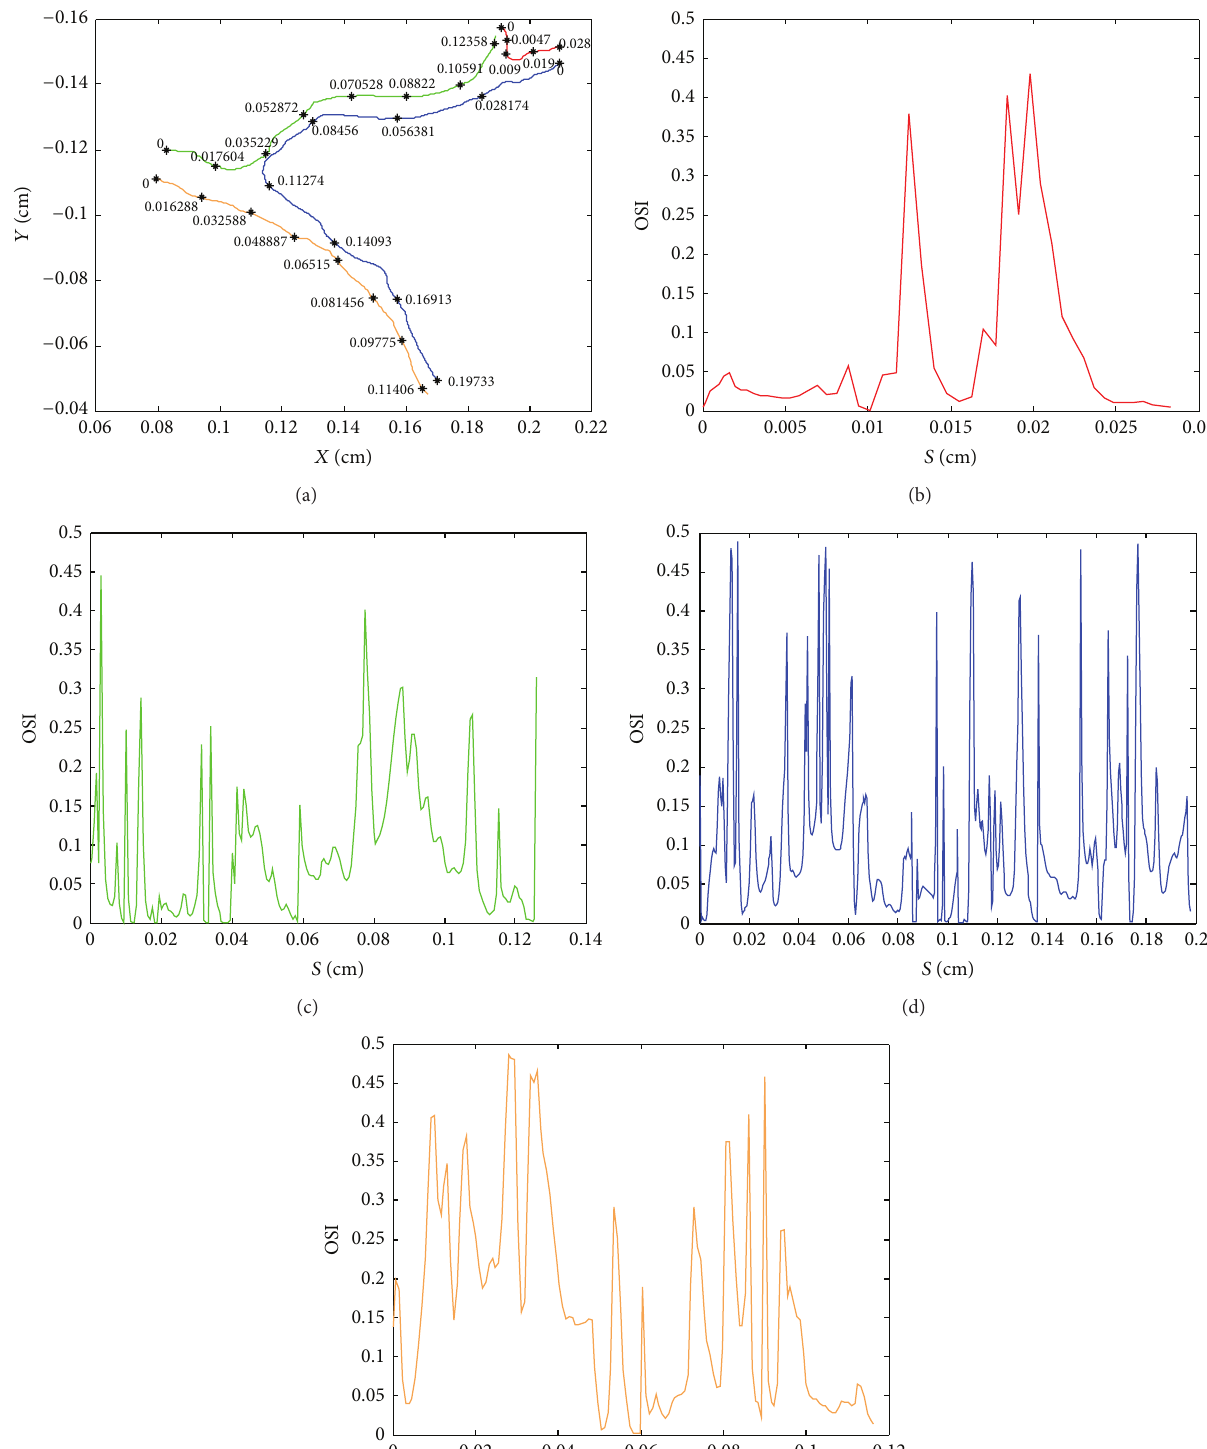
Figure9:(a)Boundaryplotsofcoronaryarterialwalls1,2,3,and4showninred,green,blue,andbrown,respectively.(b)–(e)OSIdistribution along coronary walls 1, 2, 3, and